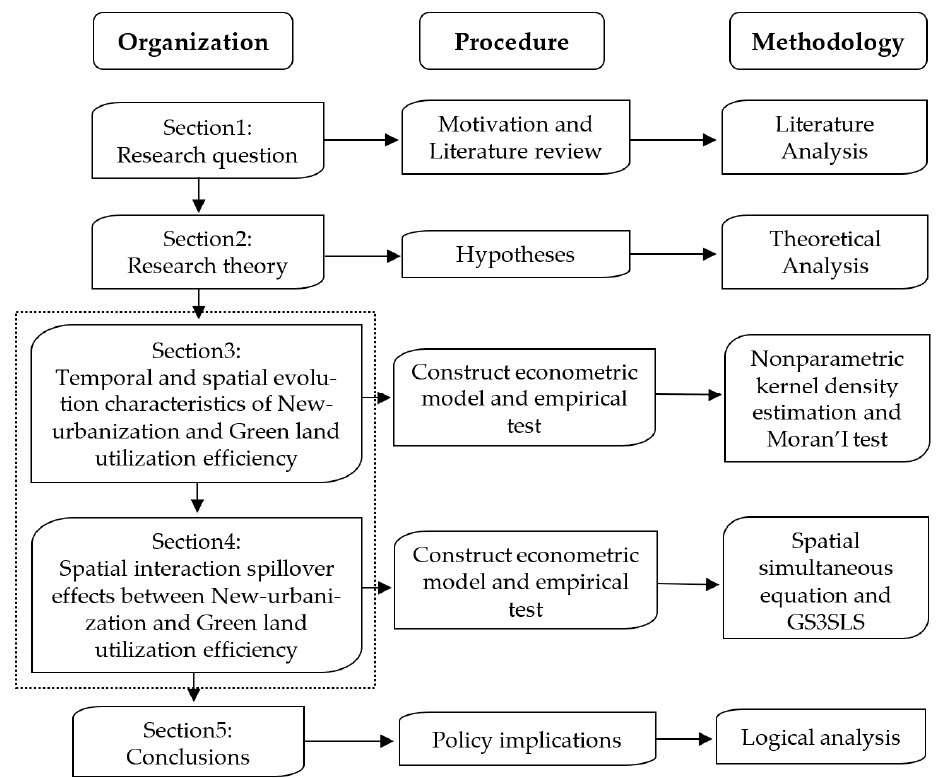
Figure 1. Research framework.